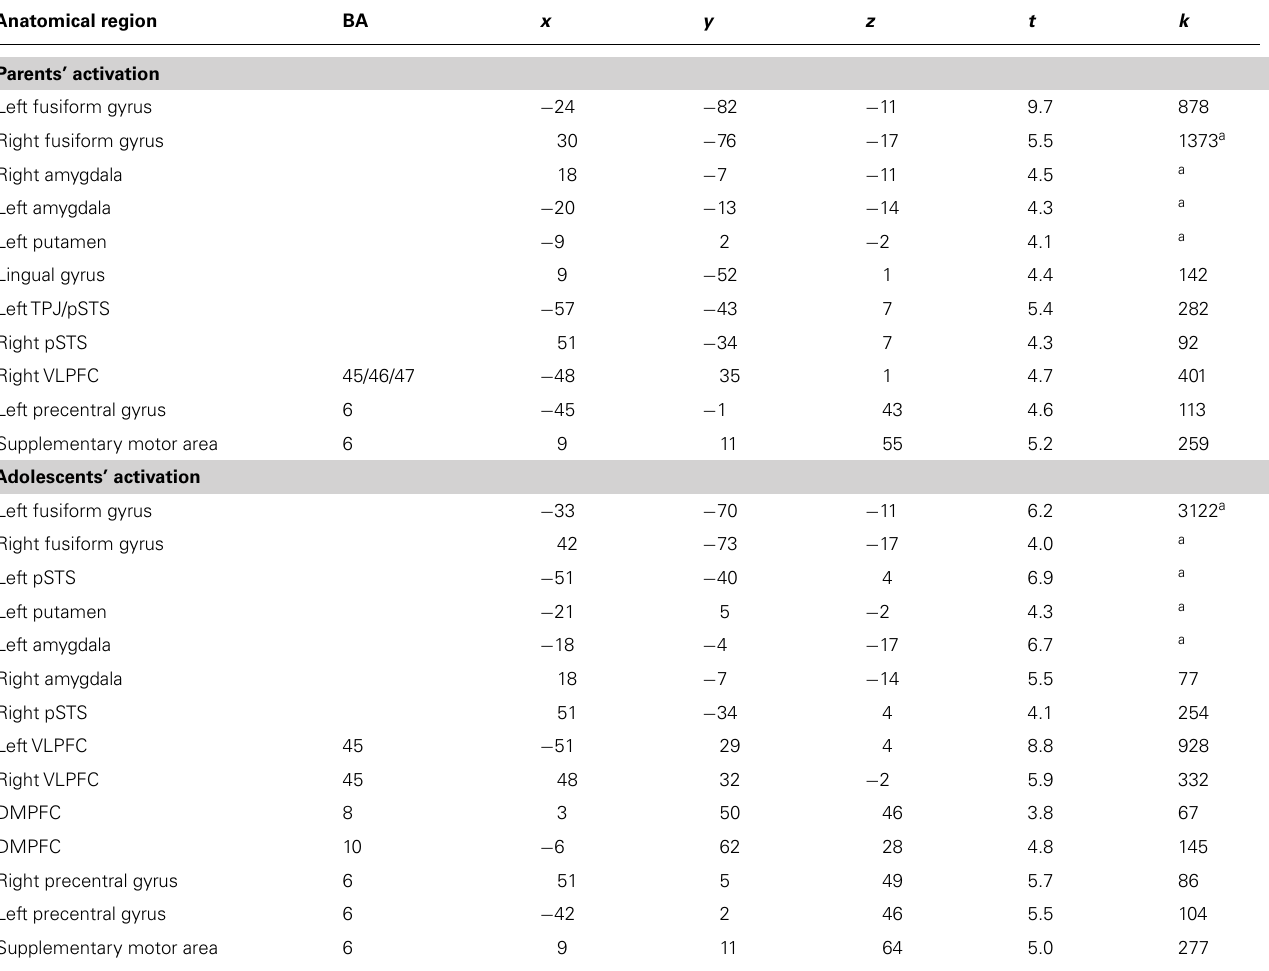
Table 1 | Neural regions activated during affect labeling versus shapes matching.